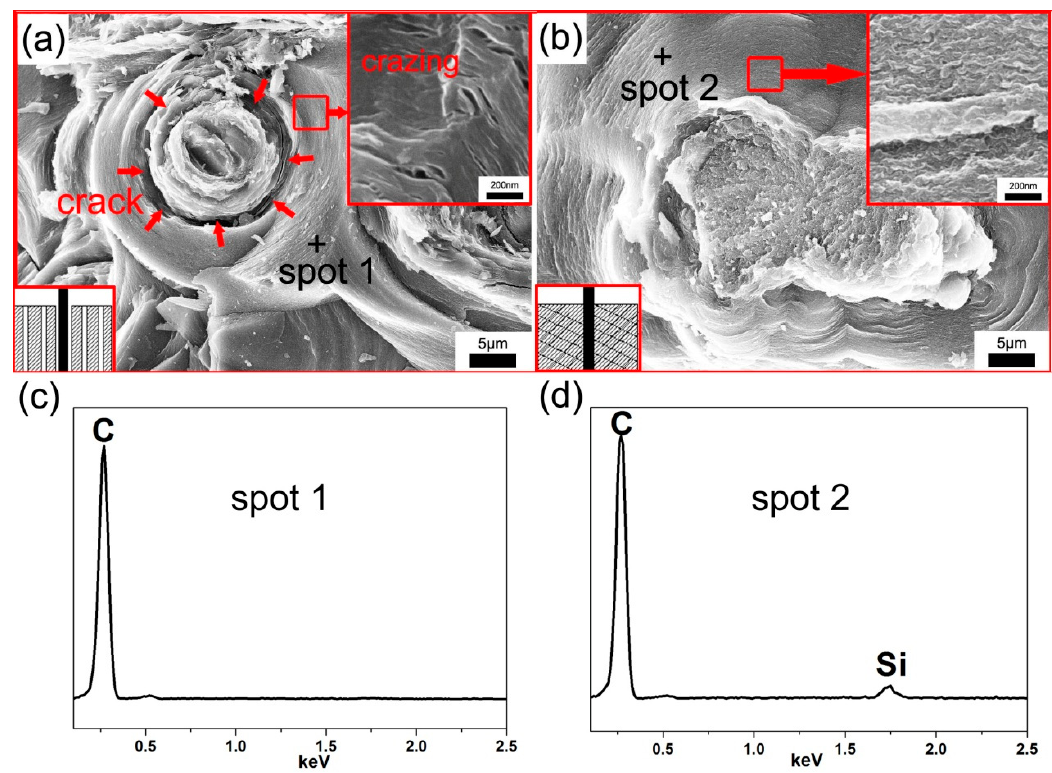
Figure 8. SEM images and EDS spectrums of the representative failure specimens from C/C ( a , c ) and SiCNW ‐ C/C ( b , d ) composites, perpendicular to fiber direction.